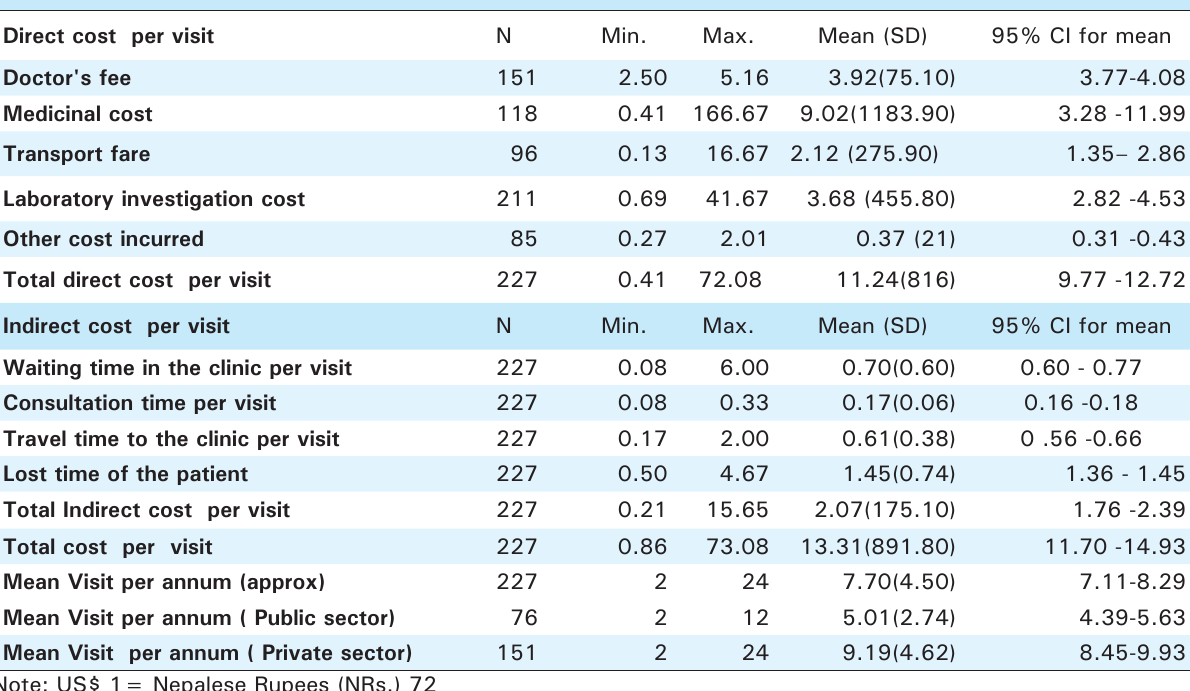
Table 1. Direct and indirect cost (in US$) incurred per visit and average number of visit per annum. Direct cost per visit